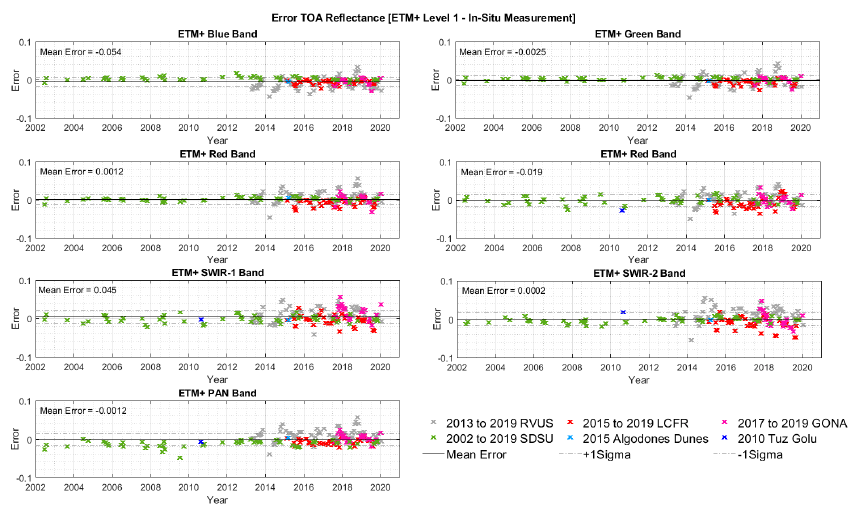
Figure 11. Scatterplots by band of Landsat-7 ETM+ Level-1 TOA reflectance data versus TOA reflectance derived from in situ measurements.